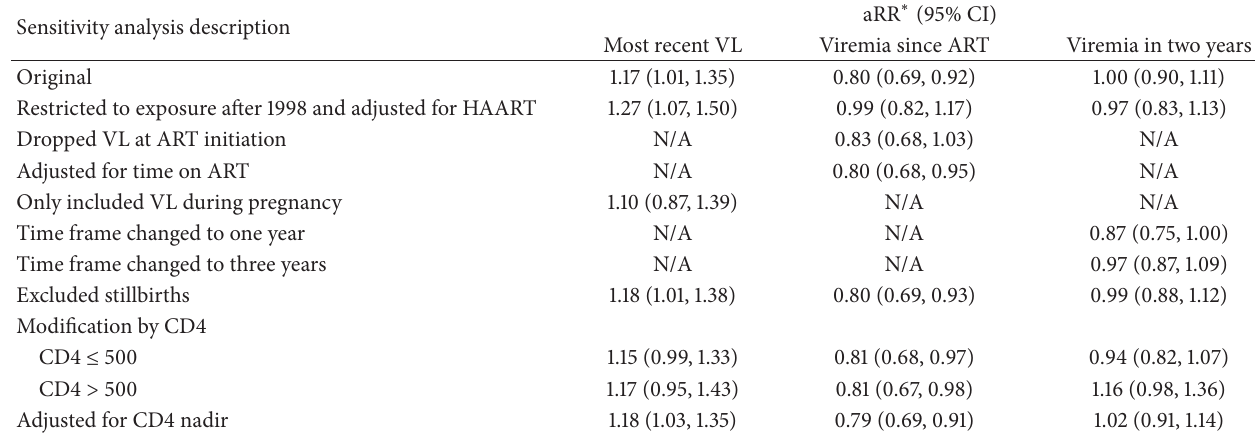
Table 3: Sensitivity analyses; adjusted ∗ risk ratios for a one-unit increase in